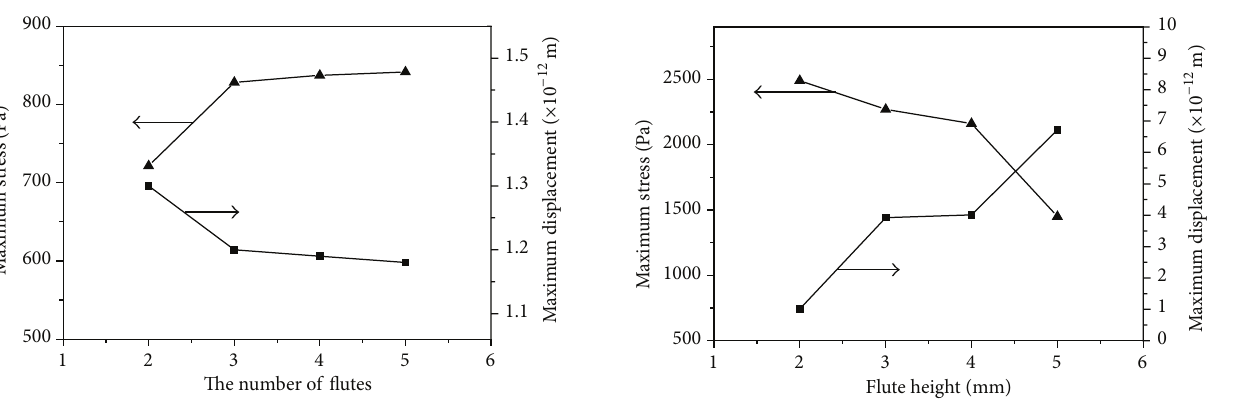
Figure 6: Maximum stresses and maximum displacements of corrugated board models with different number of flutes.